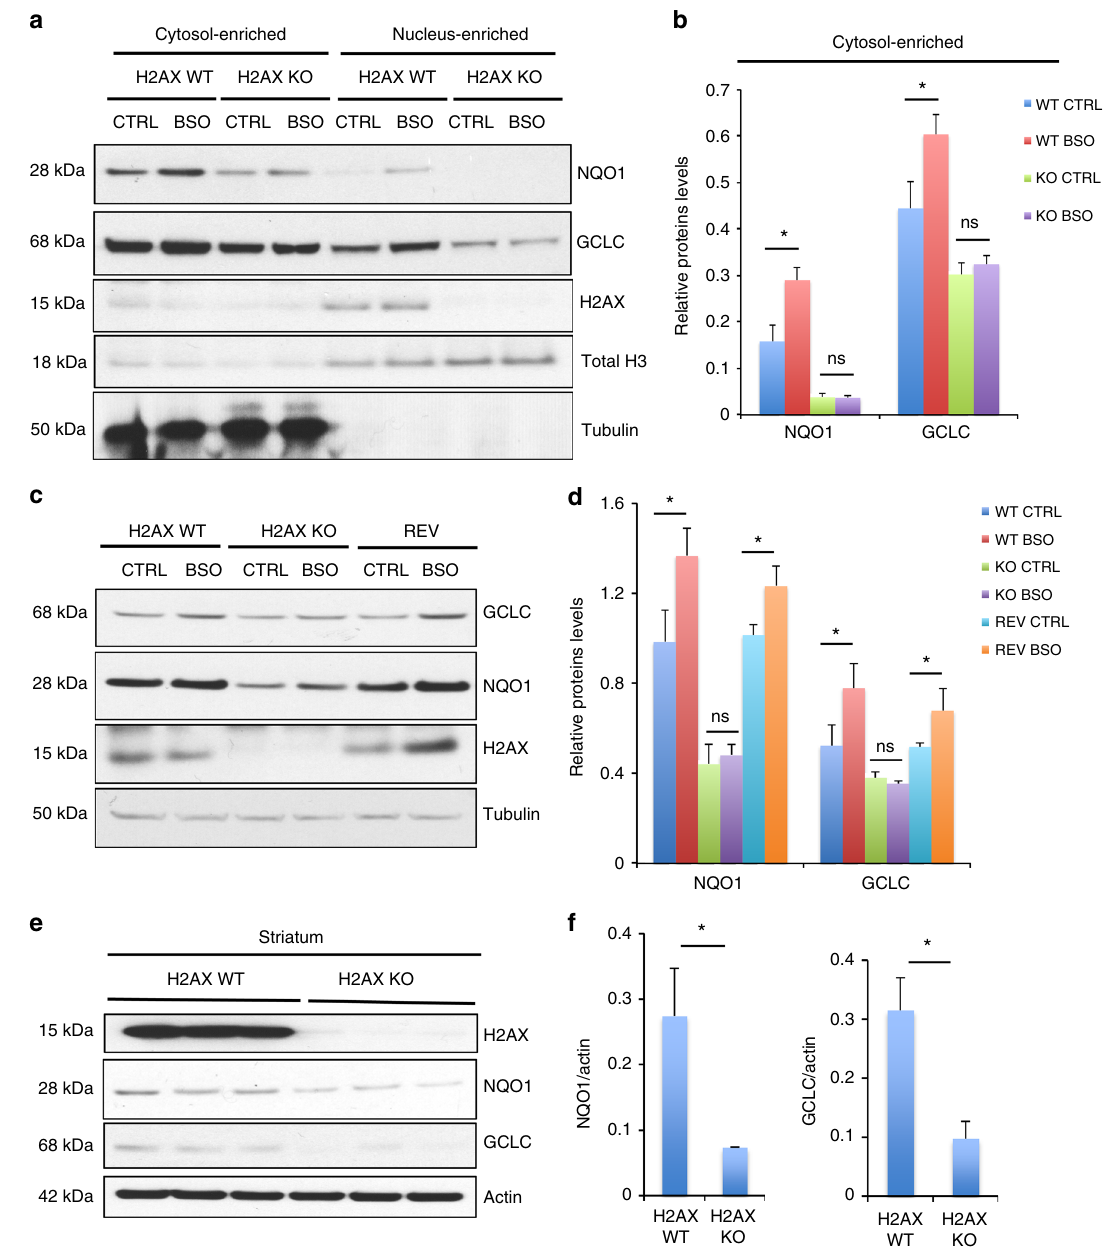
Fig. 4 H2AX de fi ciency impairs re-expression of NRF2-transcriptional targets GCLC and NQO1 in response to oxidative stress. a , b BSO treatment results in impaired activation of NQO1 and GCLC expression in H2AX mutant cells. Immunoblot analysis of GCLC, NQO1, and H2AX in parental cells (H2AX WT) and H2AX knockout cells (H2AX KO) treated for 24 h with 2 mM buthionine sulfoximine (BSO) to induce endogenous oxidative stress. Both nuclear and cytosolic fractions were analyzed to gain insights into any differential changes in NRF2-transcriptional target expression. Data indicate that mutant cells failed to restore NQO1 and GCLC in response to oxidative stress in both cytosolic and nuclear fractions; a representative image and b quanti fi cation of the cytosolic fractions of NQO1 and GCLC. Similar trend was observed in the nuclear fractions. Error bars represent the s.e.m. ( n = 3). Statistical signi fi cance was determined by a two-tailed, unpaired Student ’ s t -test. * P < 0.05, ns non-signi fi cant ( P = 0.8164 for NQO1 and 0.2783 for GCLC). c , d Immunoblot analysis of GCLC, NQO1, and H2AX in parental cells (H2AX WT), H2AX knockout cells (H2AX KO), and H2AX knockout cells in which H2AX expression was restored (Rescued), utilizing actin as a loading control. Cells were treated for 24 h with 2 mM BSO to elicit endogenous oxidative stress. c Representative image, d quanti fi cation. Error bars represent the s.e.m. ( n = 3). Statistical signi fi cance was determined by a two-tailed, unpaired Student ’ s t -test. * P < 0.05, ns non-signi fi cant ( P = 0.5241 for NQO1 and 0.2069 for GCLC). e , f Immunoblot analysis of GCLC, NQO1, and H2AX in the striatum of both wild-type and mutant mice. e Representative image, f quanti fi cation. Error bars represent the s.e.m. ( n = 3). Statistical signi fi cance was determined by a two-tailed, unpaired Student ’ s t -test. * P <